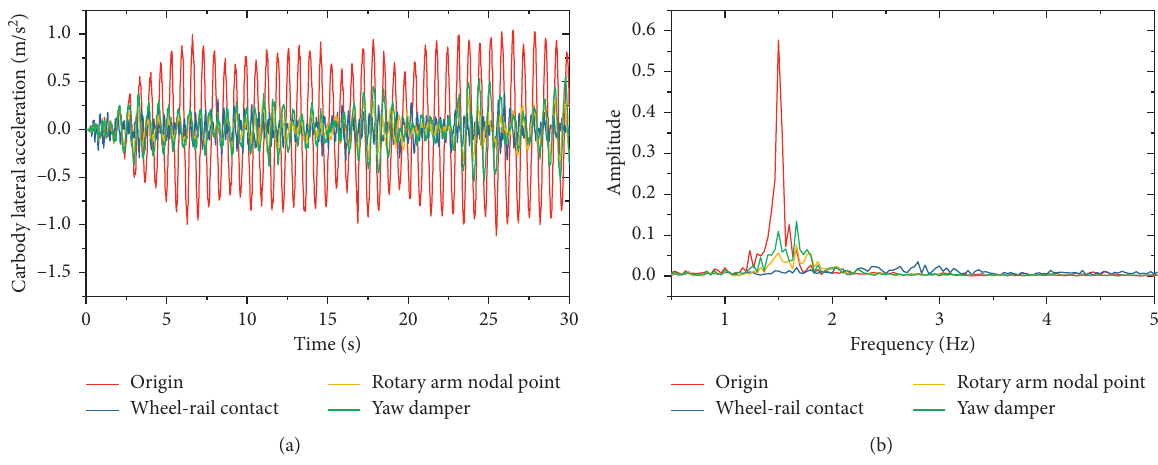
Figure 14: Improved result of different optimized methods on (a) time domain and (b) frequency